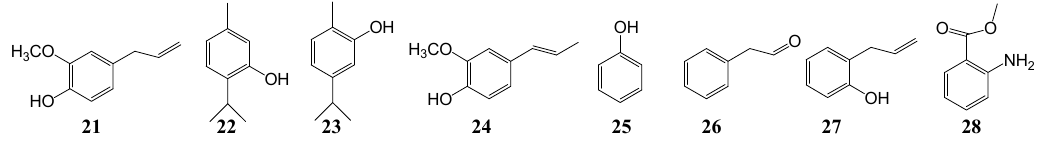
Figure 2. Chemical structures of volatile antifungal constituents 21–28 .